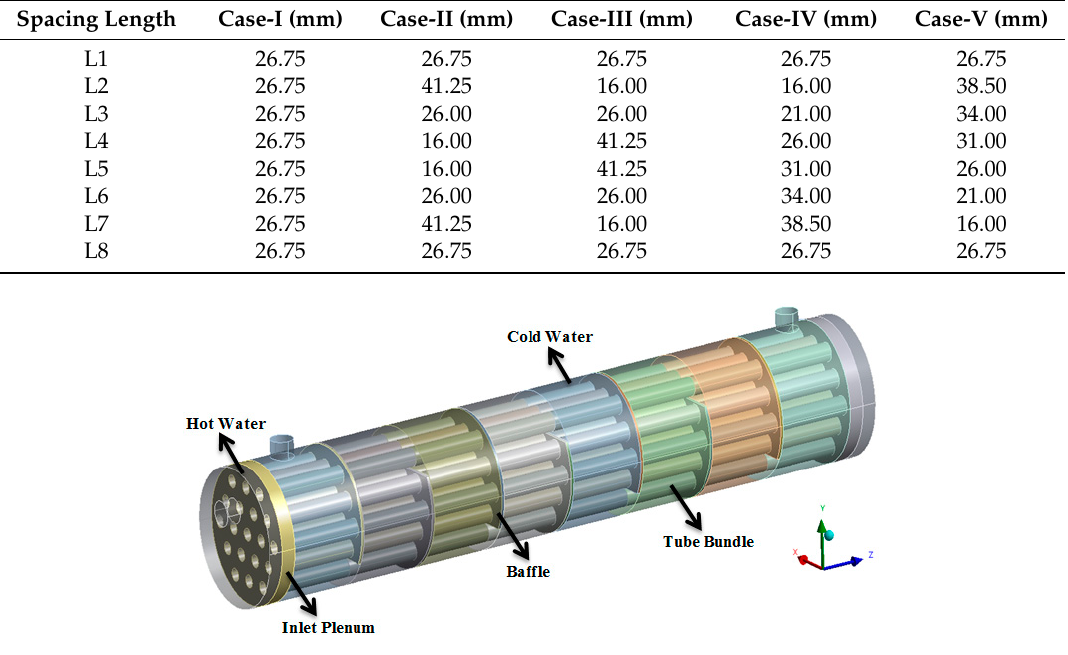
Figure 4. CAD model of the shell and tube heat exchanger used in this numerical study. Table 2. The dimensions of the shell side and tube side of the heat exchanger.